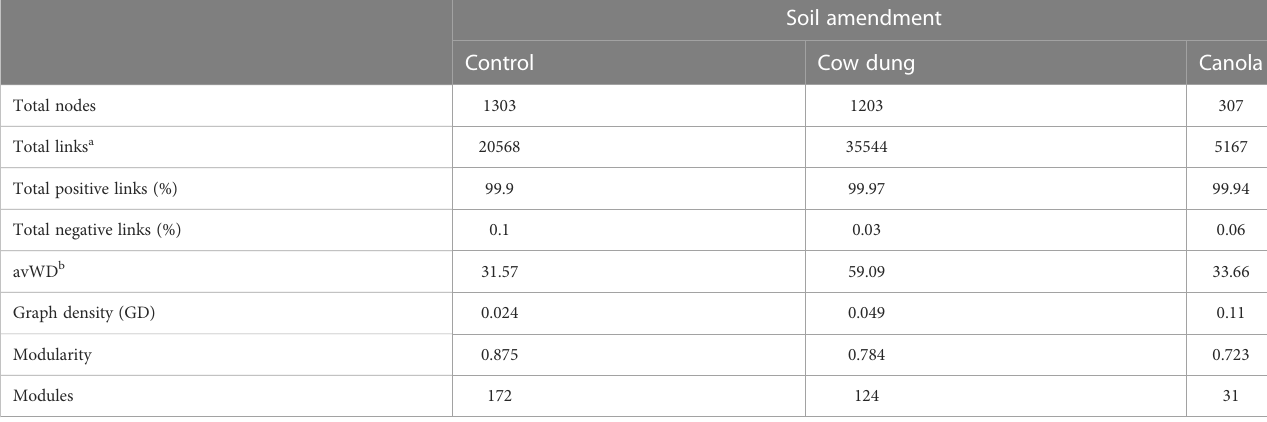
TABLE 3 Co-occurrence network topological properties of bacterial-fungal communities in soil